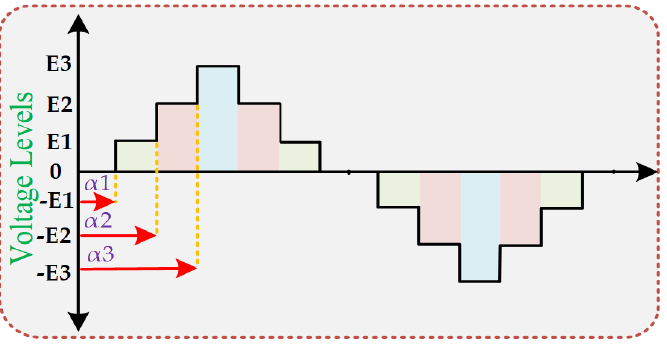
Figure 7. Seven-level output voltage.